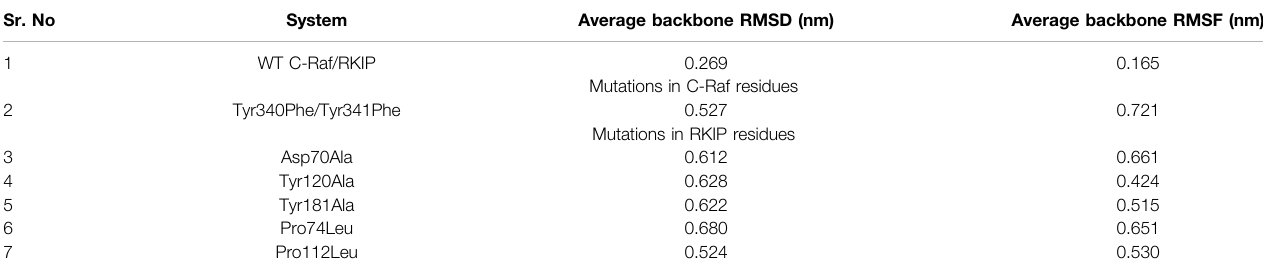
TABLE 1 | Molecular dynamics (MD) simulation trajectory analyses for wild-type (WT) and complex systems generated through mutations in conserved interface residues of C-Raf and RKIP. Sr.